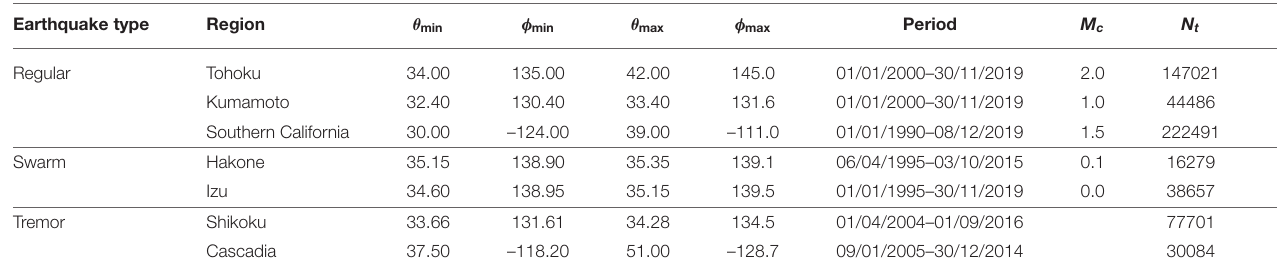
TABLE 1 | The summary of the catalog data analyzed for investigating the correlations between the earthquake events. Earthquake